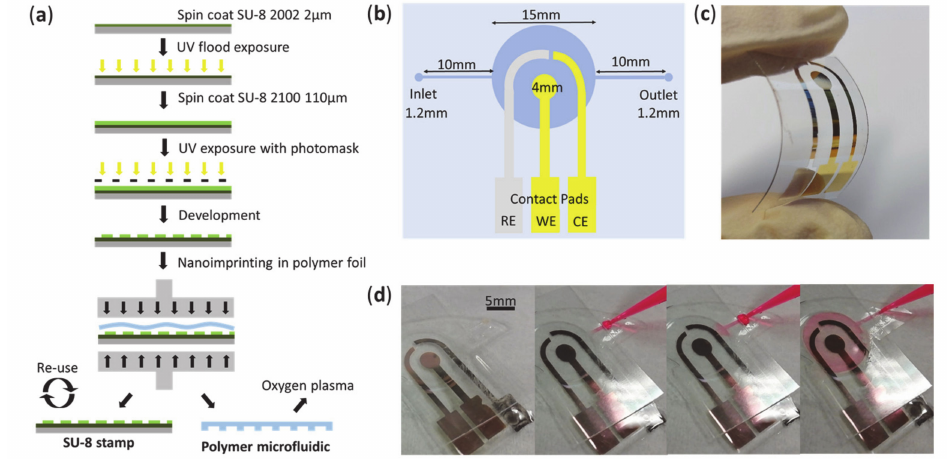
Figure 5. ( a ) Microfluidic fabrication process using nanoimprinting. ( b ) Scheme of the three-electrode system and a simple microfluidic channel. ( c ) Reference electrode (RE), working electrode (WE) and counter electrode (CE) evaporated on PS foil. ( d ) Application of dyed water to validate the filling of the